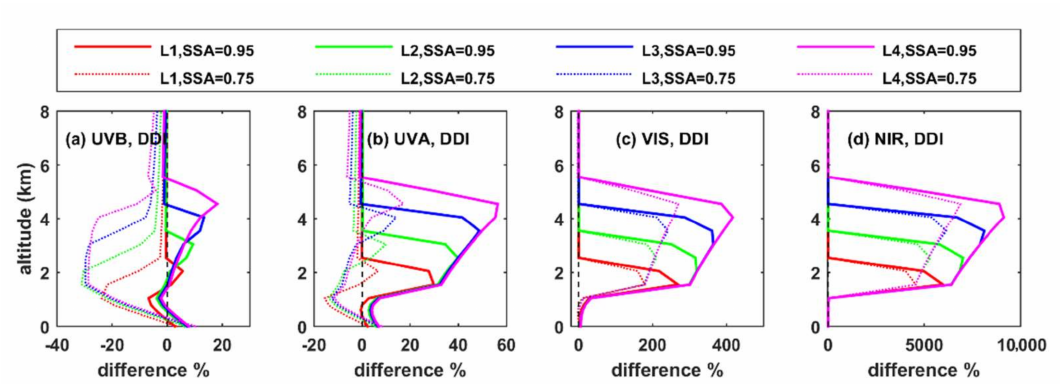
Figure A10. Same as Figure 4, but for surface albedo = 0.8 instead of surface albedo = 0.1.